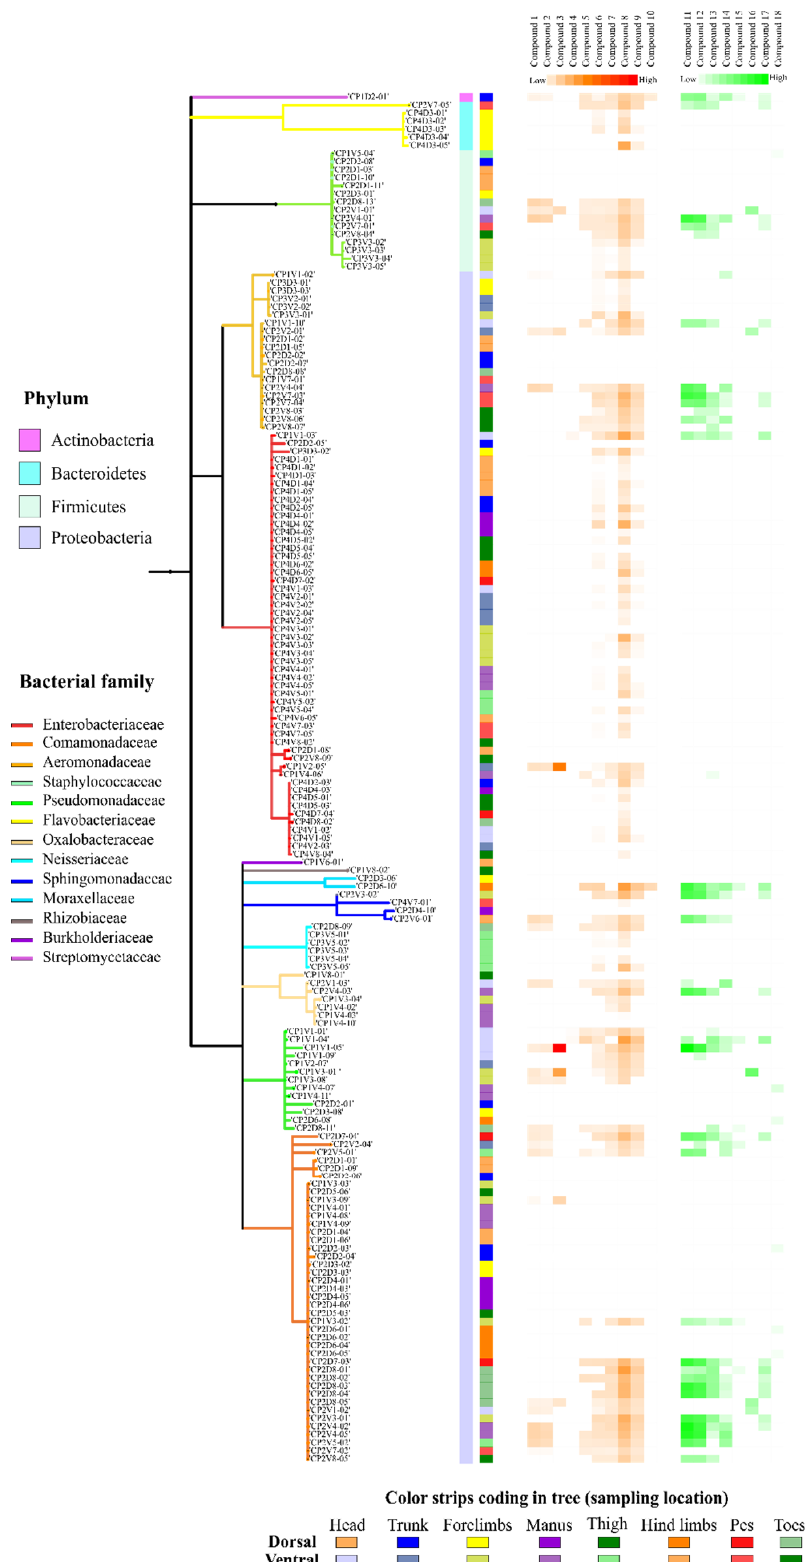
Figure 5. Phylogenetic tree and structures of annotated metabolites from 170 cultivable bacteria isolated from the skin of C. panamansis and a heatmap that displays the abundance of specialized metabolites annotated as molecular features by feature based molecular networking-analysis.